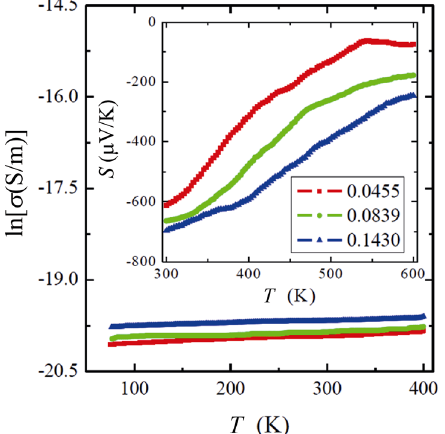
Fig. 7 Electrical conductivity (ln  ) and thermoelectric power S (inset) vs. temperature T